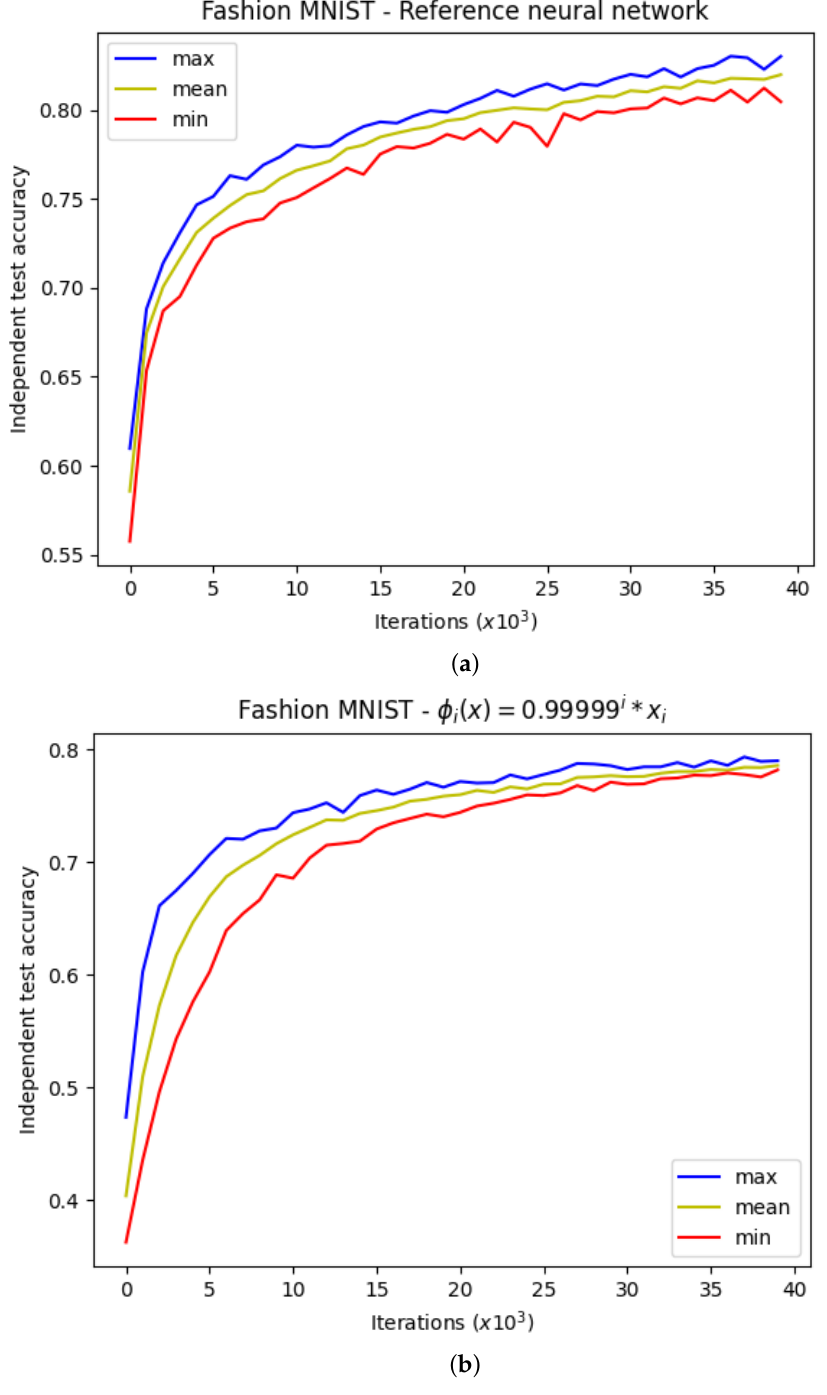
Figure 8. This figure plots the mean, minimal, and maximal classification accuracies during training, averaged from five independent training sessions on the Fashion-MNIST dataset. The top image ( a ) depicts the classification accuracies with the reference convolutional neural network (baseline), while the lower image ( b ) plots the same results using an SAW convolution-based kervolutional neural network with an attenuation parameter of 99,999. The blue color is the maximum accuracy, the yellow color is the mean accuracy, and the red line shows the minimum accuracy. As can be seen, there were no significant differences between the two